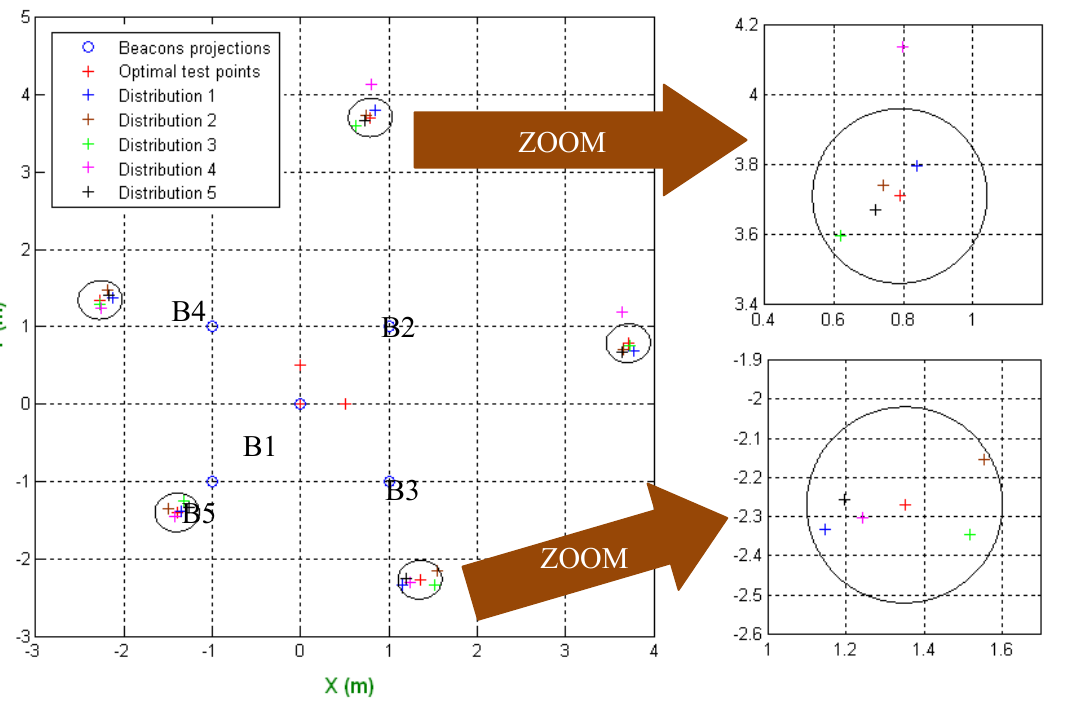
Figure 2. Distribution of the unknown test points around the location of the optimal test